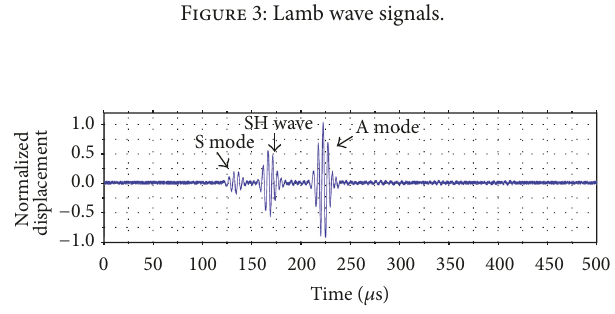
Figure 4: Residual signal.